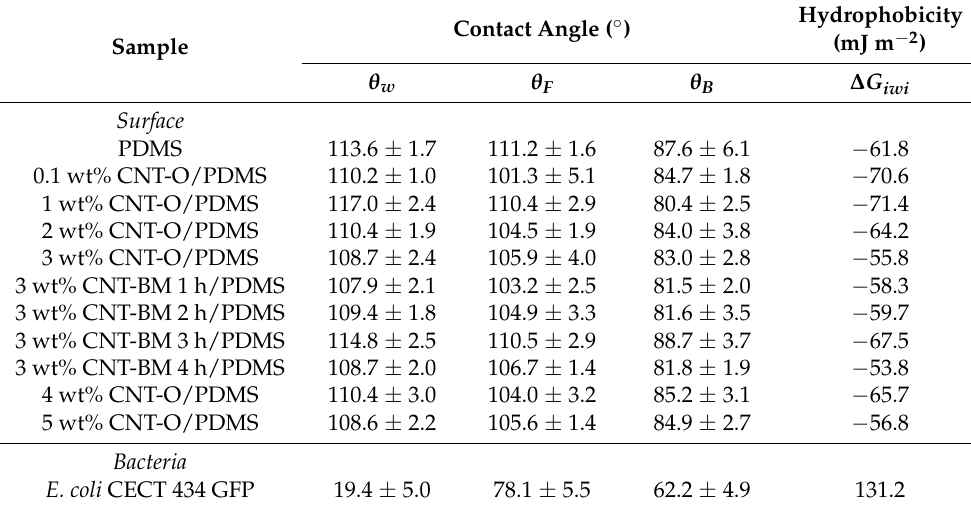
Table 2. Contact angles with water ( θ w ), formamide ( θ F ) and α -bromonaphthalene ( θ B ), and free energy of interaction ( ∆𝐺 𝑖𝑤𝑖 ) between two entities of a given material ( i ) (surface or bacteria) when immersed in water ( w ). Values are means ± standard deviations (SDs) of three independent experi- ments.